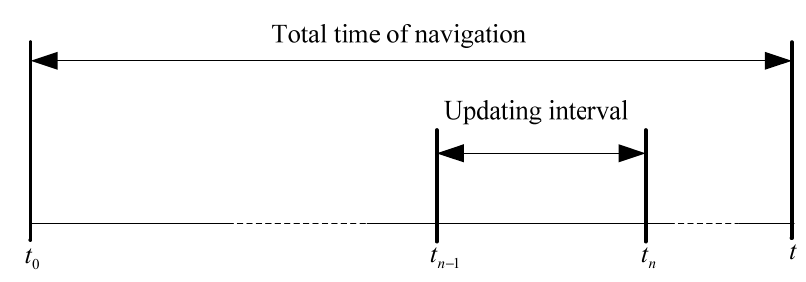
Figure 1. Intervals associated with strapdown